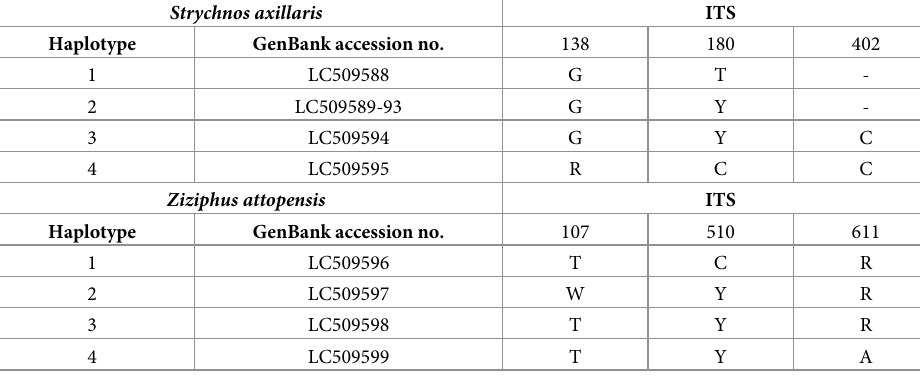
A = adenosine, C = cytosine, G = guanine, R = guanine or adenosine, T = thymine, W = adenosine or thymine, Y = thymine or cytosine,— = absence of base nucleotide.